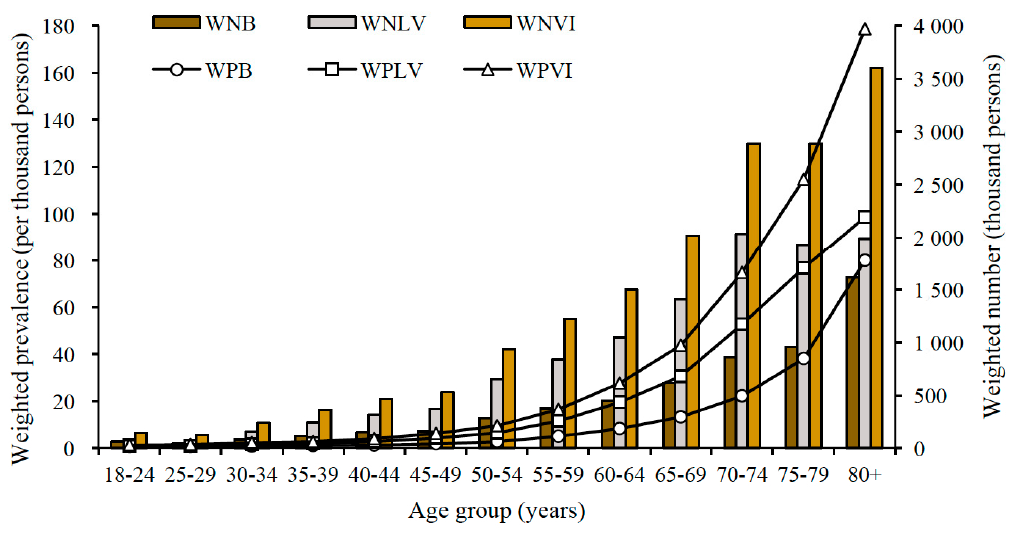
Figure 1. The estimated number and weighted prevalence of low vision, blindness, and visual impairment among Chinese adults, by age group. Note: WNB = weighted number of blindness; WNLV = weighted number of low vision; WNVI = weighted number of visual impairment; WPB = weighted prevalence of blindness; WPLV = weighted prevalence of low vision; WPVI = weighted prevalence of visual impairment.